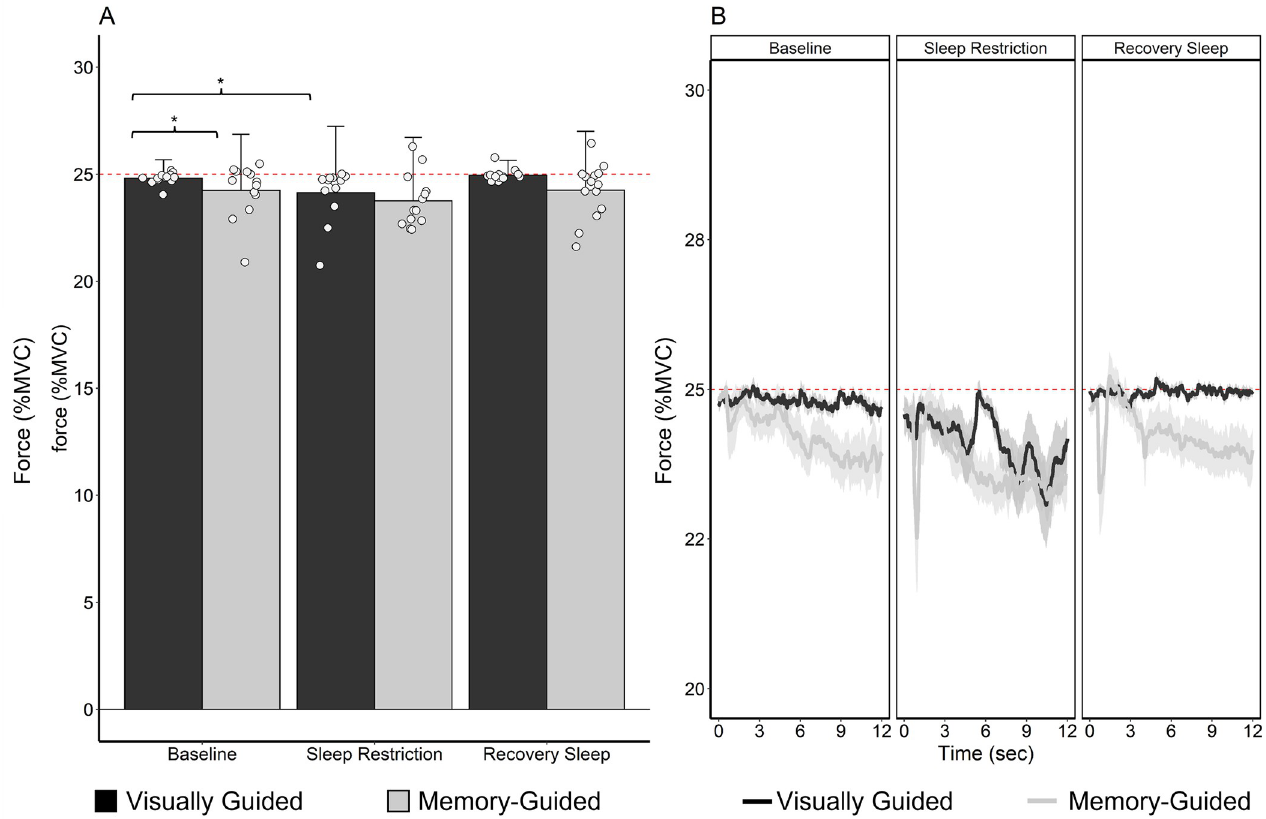
Fig 3. Force production as a percentage of maximum voluntary contraction (MVC) plotted by day and vision condition. The red dashed line indicates the target force (25% MVC). A) Average force production over the last 12 s of each trial. The black bar indicates the visually guided condition, and the grey bar indicates the memory-guided condition. Error bars indicate the standard deviation of the mean. Open circles represent each individual participant’s mean force. ��� p < 0.001; �� p < 0.01; � p < 0.05. B) Force production over the last 12 s of each trial. The dark black line indicates the visually guided condition, and the grey line indicates the memory-guided condition. Shaded areas represent the standard error of the mean.